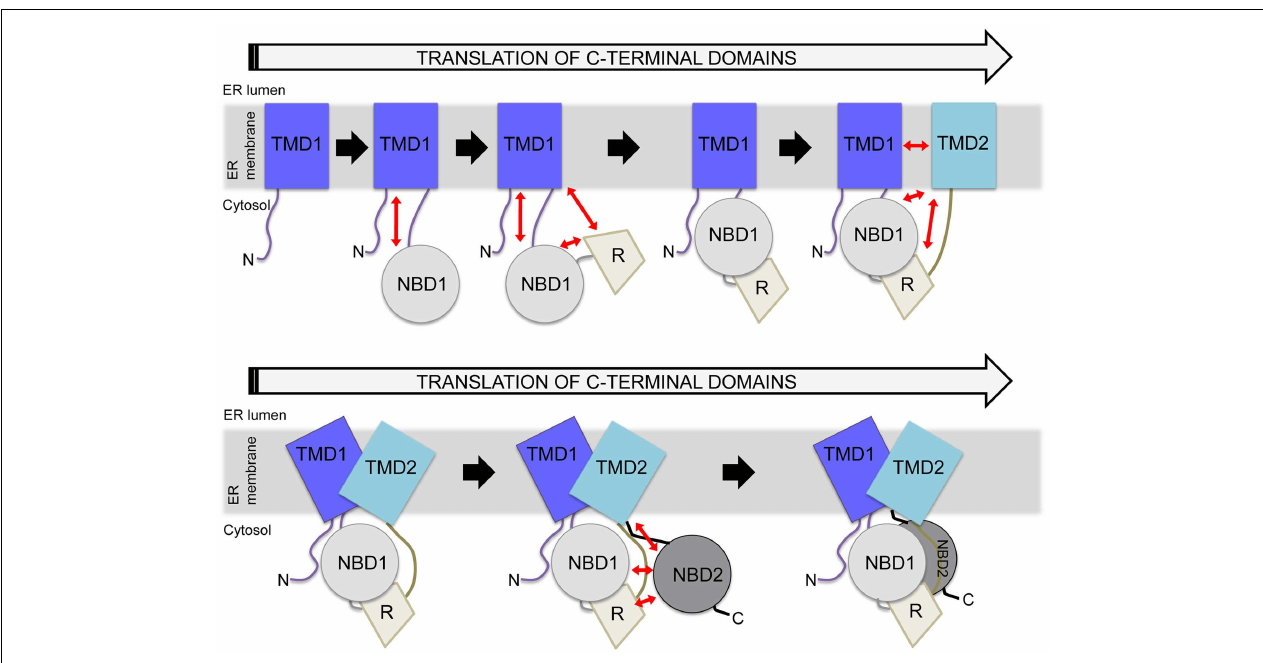
from the ER. Reflecting this, a major structural rearrangement is depicted in the presence ofTMD2, as shown in the bottom panel. Eventually, NBD2 is incorporated as the final step.There are many points during this process at which the cell may monitor